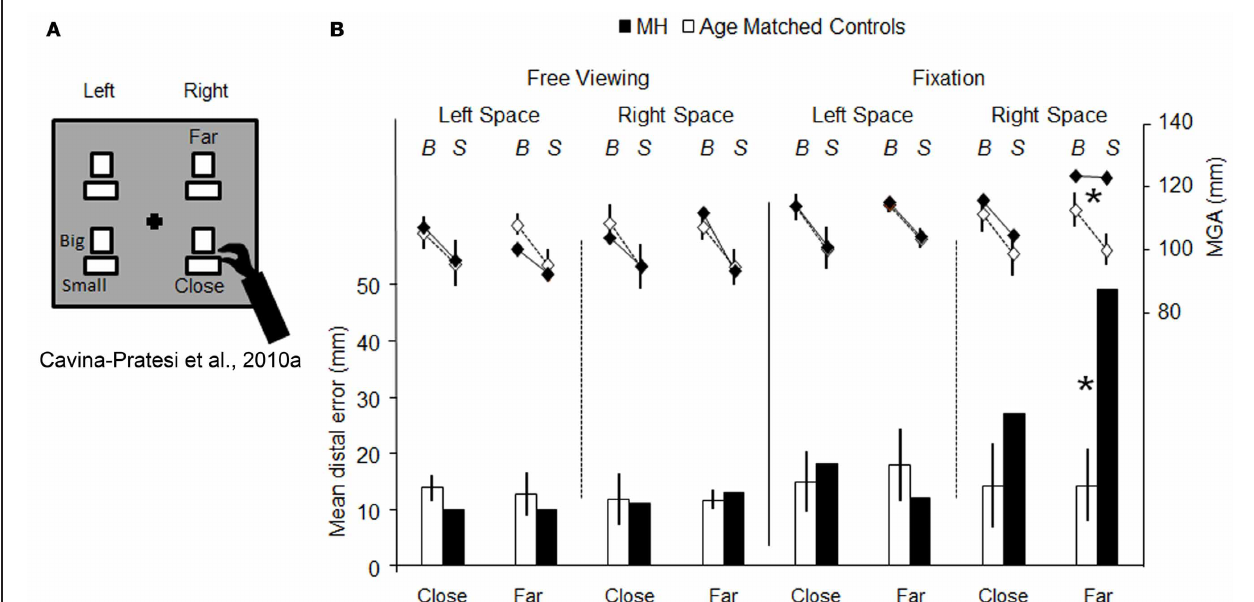
FIGURE 3 | Schematic representation of the set-up used for testing reaching vs. grasping behavior, and the results obtained. (A) is a schematic representation of the set-up used by (Cavina-Pratesi et al., 2010a). The black cross depicts the fixation point and the white rectangles show the possible target locations (only one target at a time was presented) and the possible sizes of the objects to be grasped (“Big” and “Small”). Patient M.H. and age-matched controls were asked to grasp objects that could be located either close to the hand (i.e., did not require any arm reaching) or far from the hand (i.e., requiring arm reaching). Graph (B) summarizes the key results for both reaching (bar graph, below) and grasping (line graph, above). The bar graph depicts the reaching error as